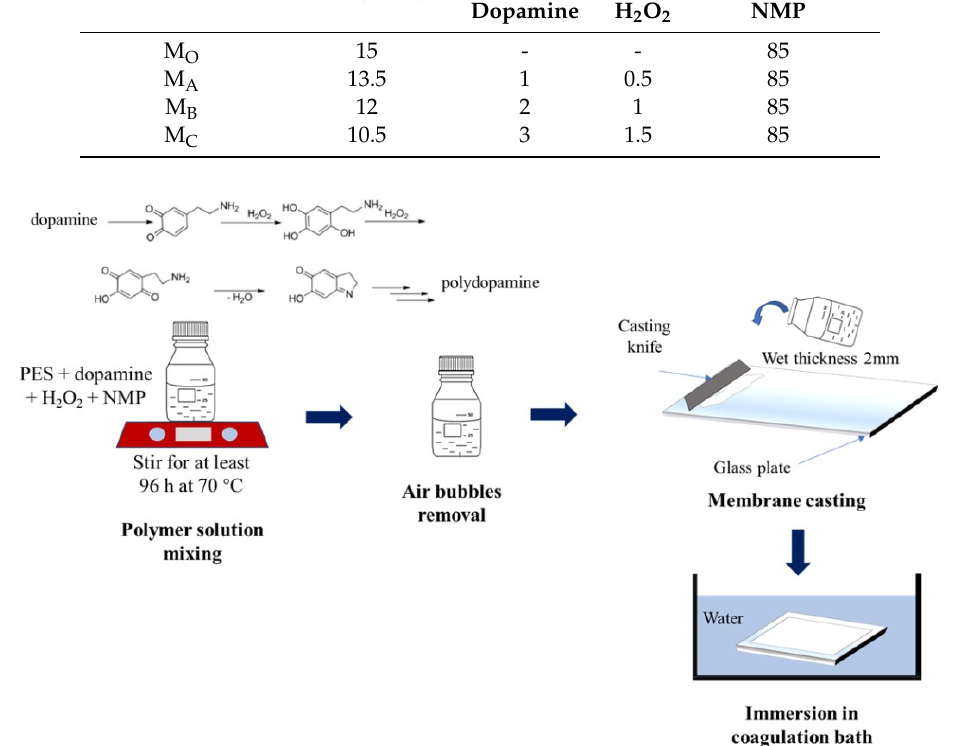
Figure 1. Illustration of membrane fabrication method showing the step of dophamine polymerization . Table 1. Compositions of dope solution for membrane preparation.